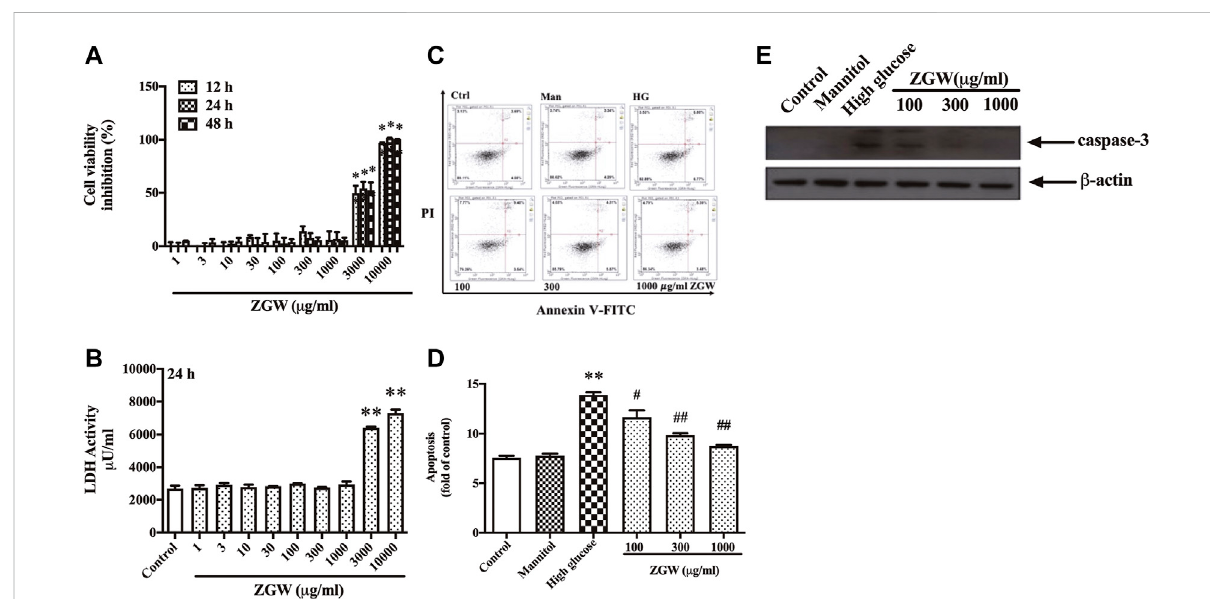
FIGURE 5 EffectsofZGWonviability,necrosis, andapoptosis.PodocyteswereincubatedwithincreasingconcentrationsofZuoguipill(0,1,3,10,30,100, 300,1,000,3,000,and10,000 μ g/ml). (A) CellviabilitywasexaminedusingCCK-8assayafter12,24,and48 htreatmentwithZuoguipill. (B) Necrotic cell death was assessed by the release of LDH after 24 h treatment with Zuogui pill. (C) Podocytes were preincubated with Zuogui pill by 100, 300, and 1,000 μ g/ml for 1 h then exposed to high glucose (30 mM). Effects of Zuogui pill on apoptosis were assessed by FACS after annexin V/PI staining. Representative fl ow cytometry results for podocytes under different culture conditions. (D) Semiquantitative data showing percentage